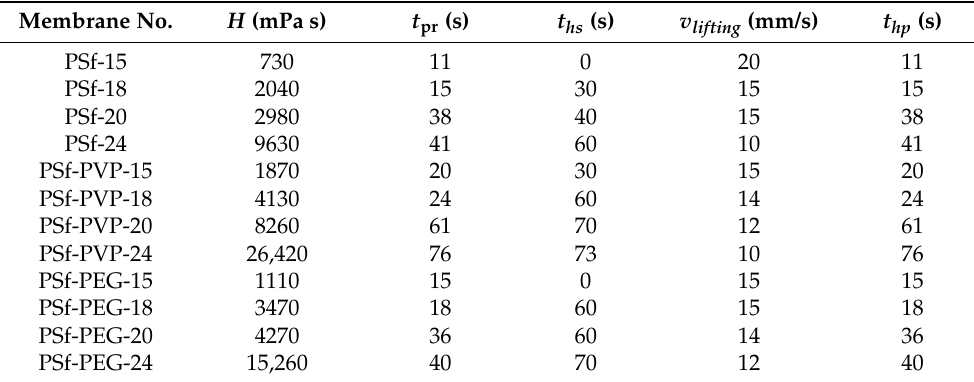
Table 3. Forming parameters for short-samples of HF PSf membranes. Membrane